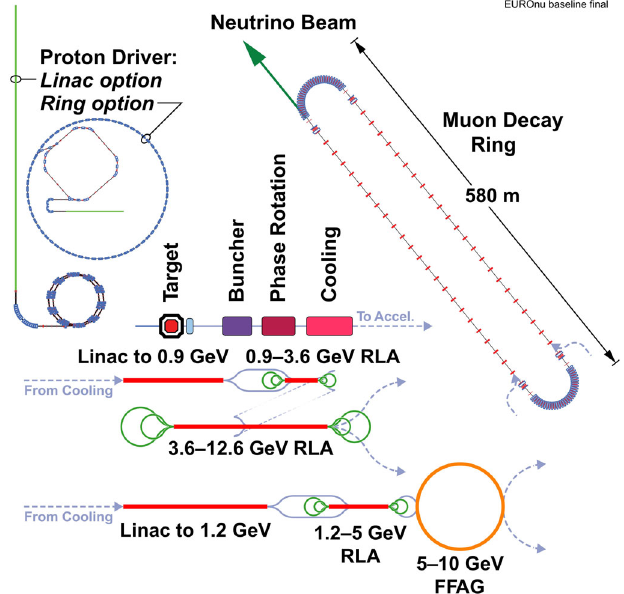
FIG. 2. Schematic diagram of the Neutrino Factory accelerator facility. The function of the various accelerator systems is described in the text. The design is a development of that described in